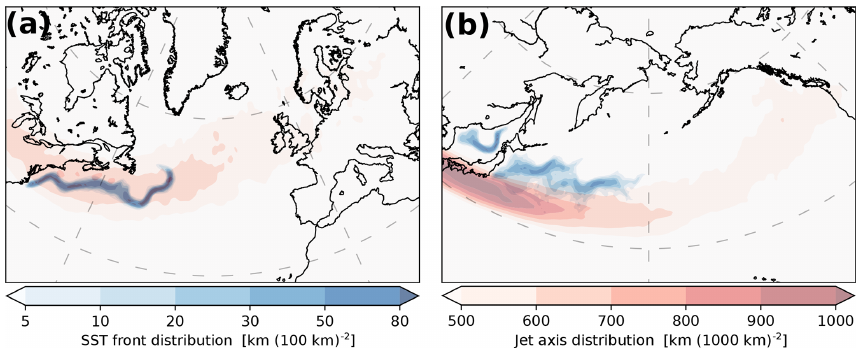
Figure 3. (a) SST front distribution (blue shading, kilometre of line (100km) − 2 ) and jet axis distribution (pale red shading, kilometre of jet axis line (1000km) − 2 ) for the North Atlantic. (b) As panel (a) but for the North